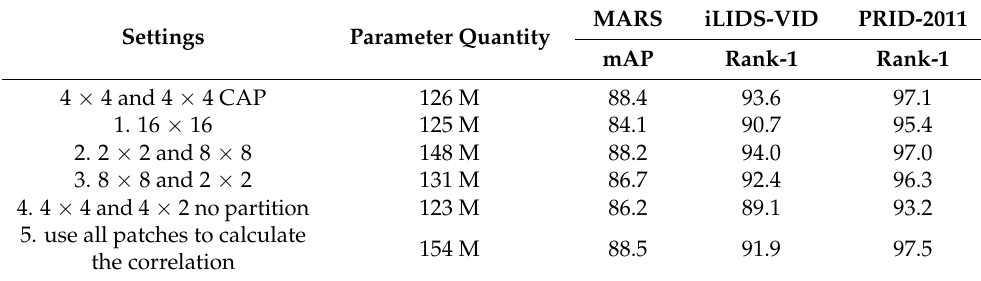
Table 2. Ablation experiment results for CAP module.